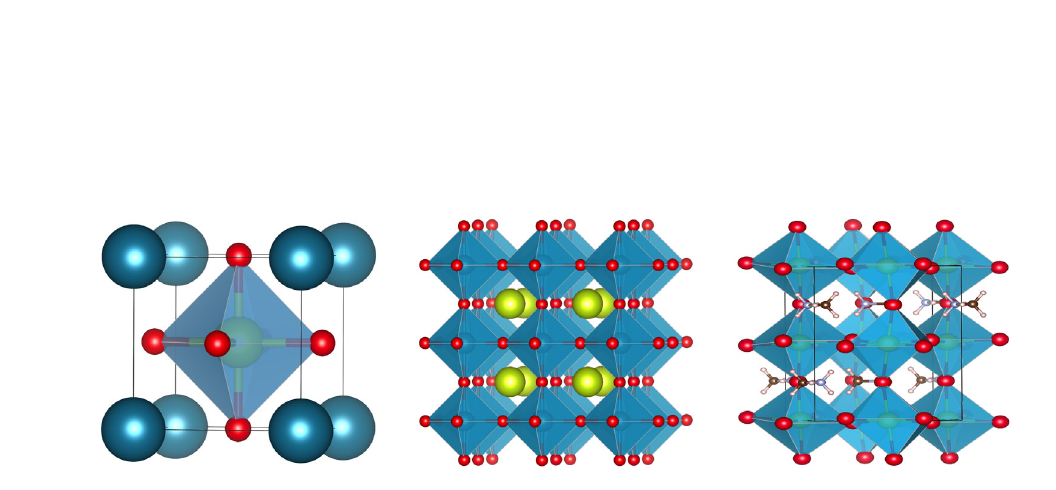
Fig. 11. – Perovskite crystal structure [69]: cubic cell structure (left), crystal overview (middle) and crystal with organic cations